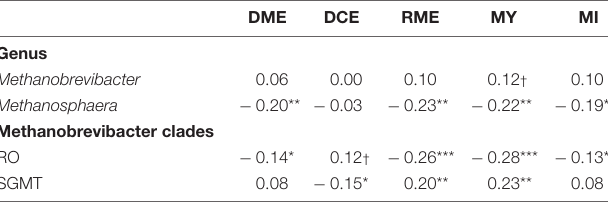
TABLE 5 | Correlation coefficients amongst rumen methanogens and traits associated with enteric